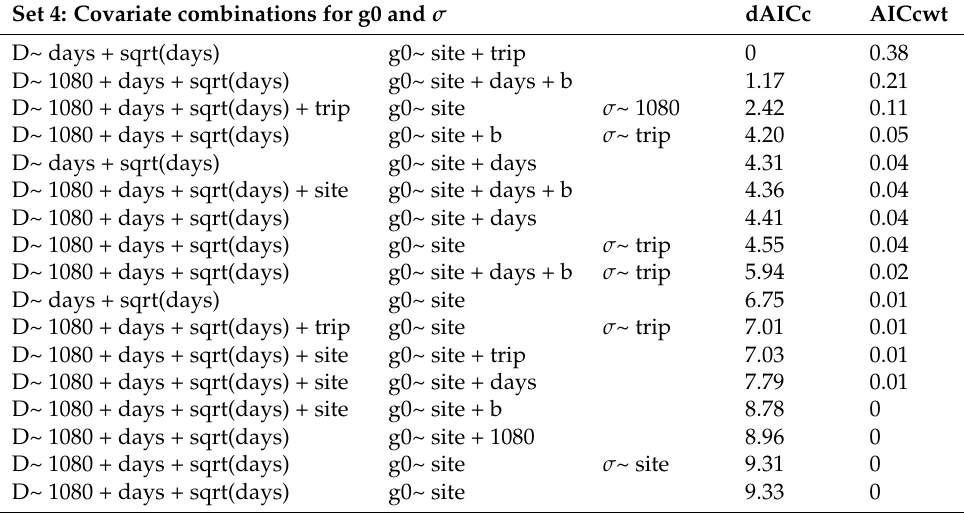
Table 3. Summary of model set 4 (all models with dAICc < 10). Set 4: Covariate combinations for g0 and σ